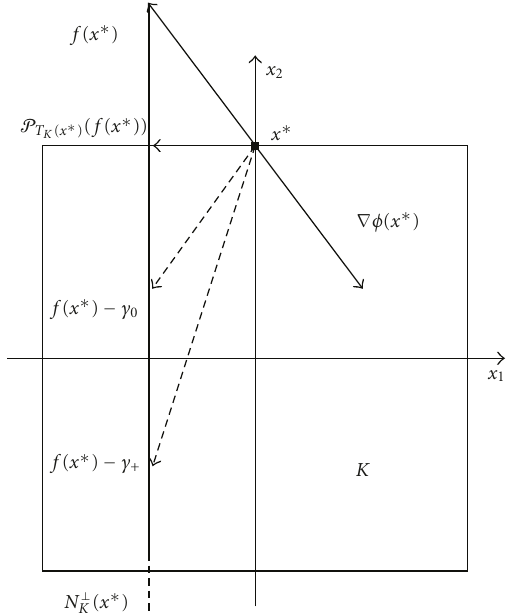
Figure 4: Comparison between the derivative Dφ in Definition 1, and the derivative (cid:12) Dφ in [21], for the second-order FR-CNN (41). The point x ∗ = (0,1) (cid:3) lies on an edge of K such that T K ( x ∗ ) =